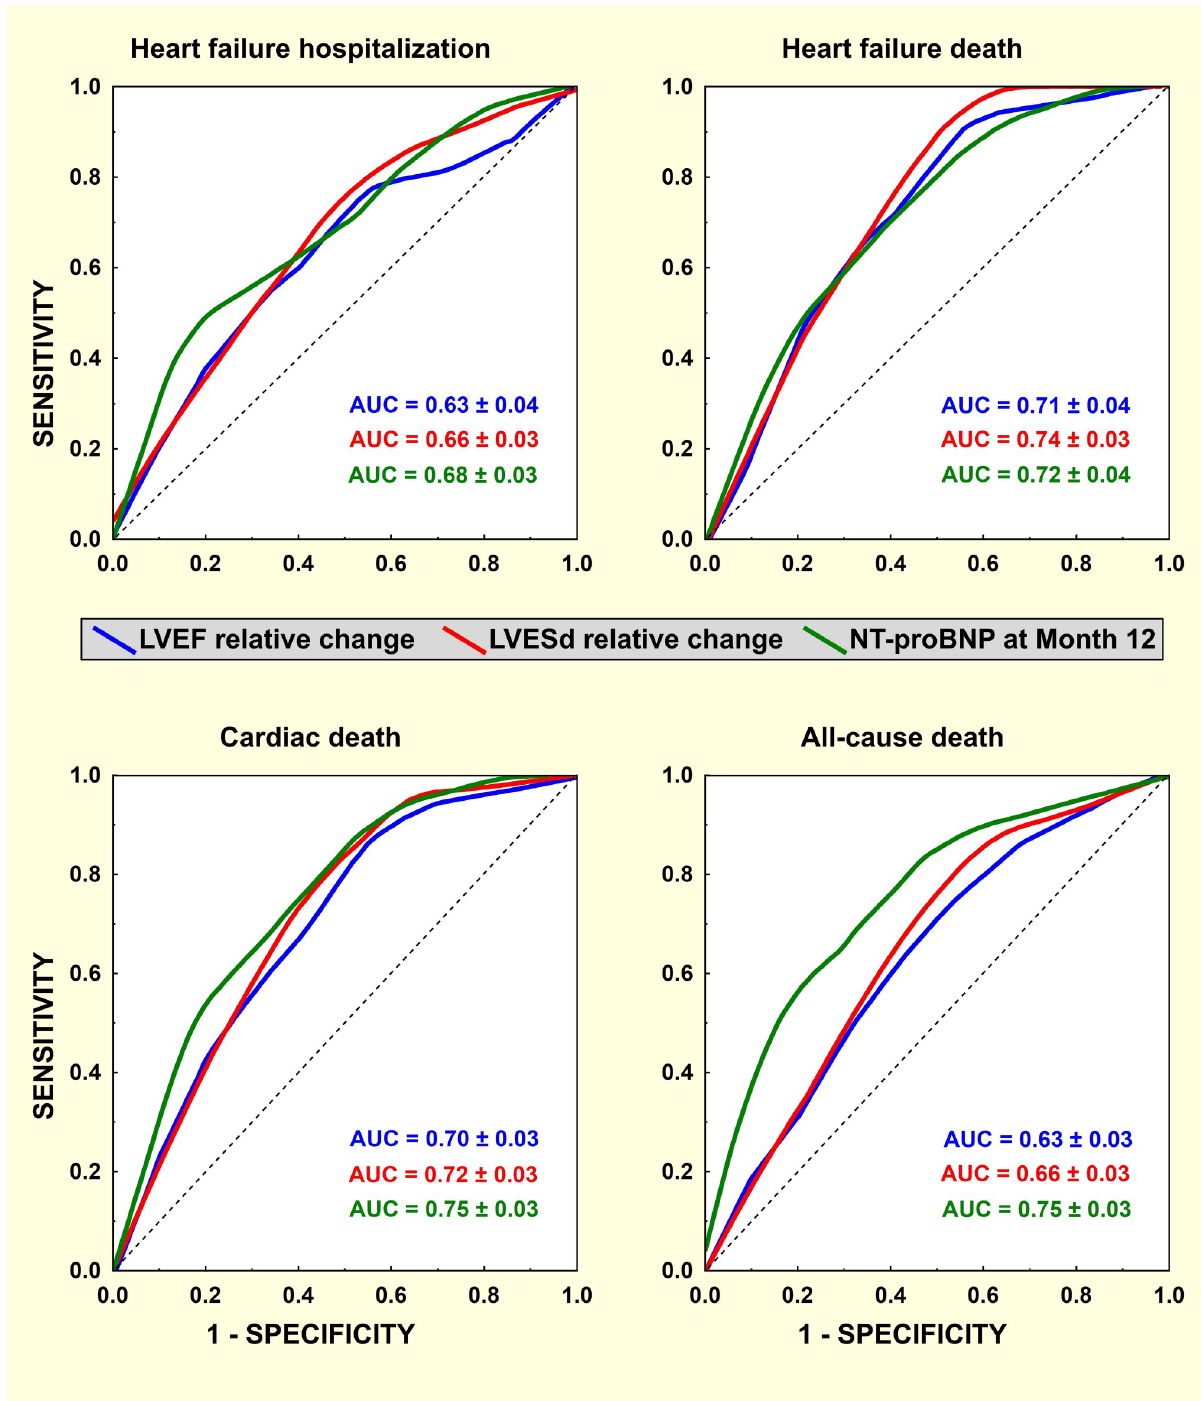
Fig 1. Receiver-operating characteristics for 12-month response to CRT and clinical events. Receiver-operating curves for post-CRT relative change in LV ejection fraction (LVEF, blue), end-systolic diameter (LVESd, red) and 12-month NT-proBNP level (green) and subsequent clinical events (heart failure hospitalization / death and cardiac/ all-cause death). The curves were obtained by locally weighted scatterplot smoothing. Areas under the curve with standard error are shown inside the graphs.